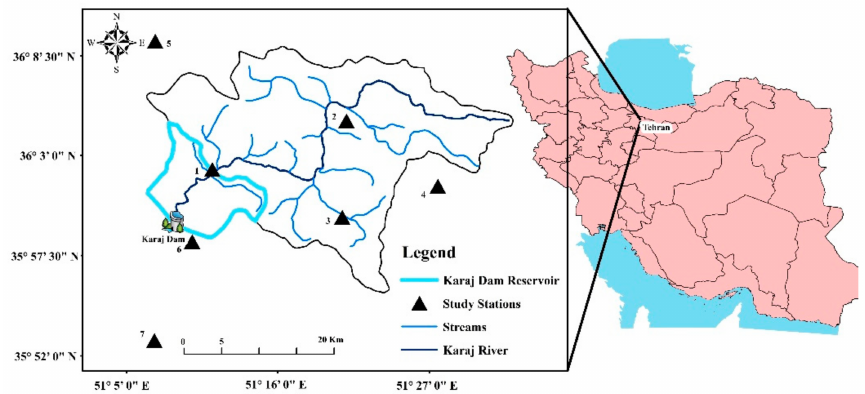
Figure 1. Study basin and reference stations used in this